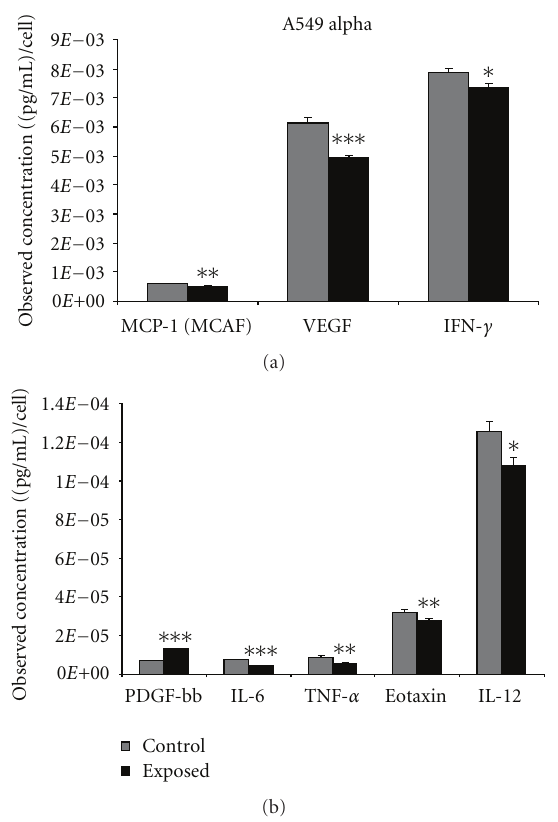
Figure 1: A549 cells were seeded into Mylar dishes and exposed to α -particle radiation at 0 and 1.5Gy. A Bio-plex cytokine assay was performed quantitating 27 di ff erent cytokines, and the results showing statistical significance between control and exposed groups are presented. ∗ represents P < 0 . 05, ∗∗ represents P < 0 . 01, and ∗∗∗ represents P < 0 . 001, n = 5 biological replicates performed in duplicate. Bars are plotted as cell count corrected means ± SEM.